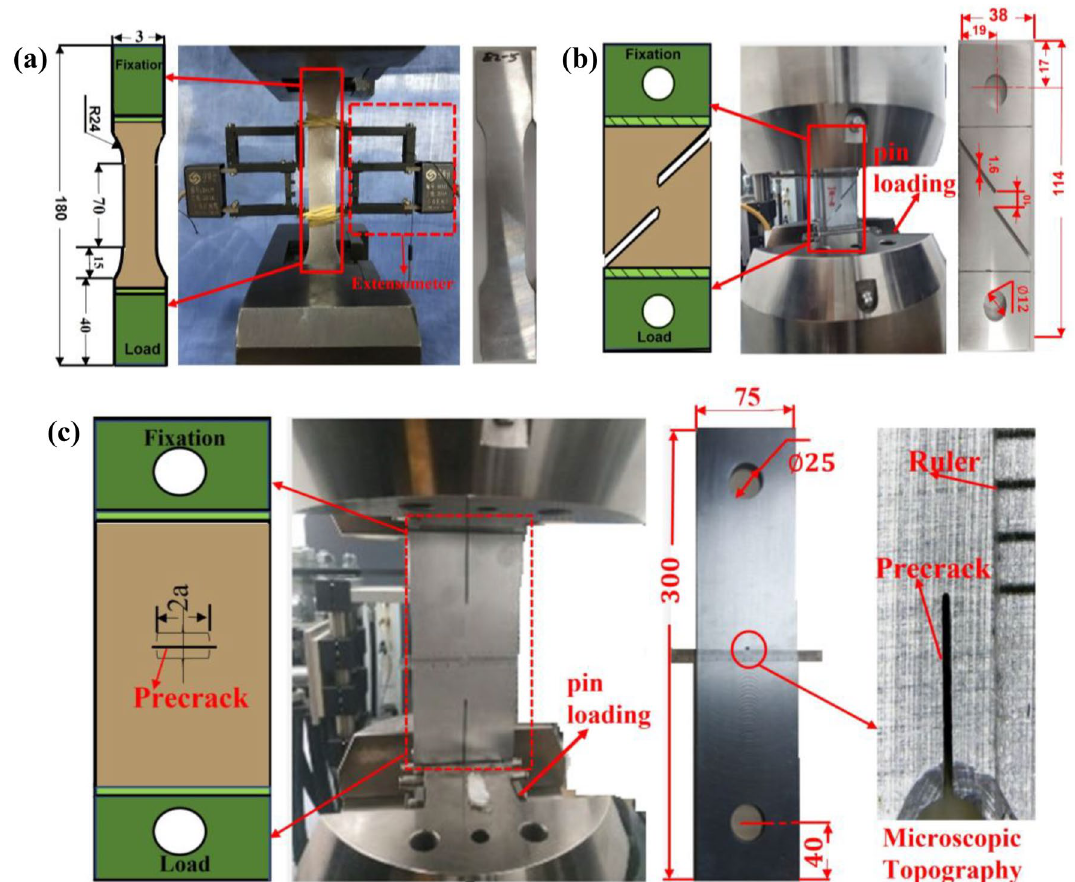
Figure 1. Schematic diagram of the test. ( a ) tensile test ( b ) shear test ( c ) Crack growth rate test.